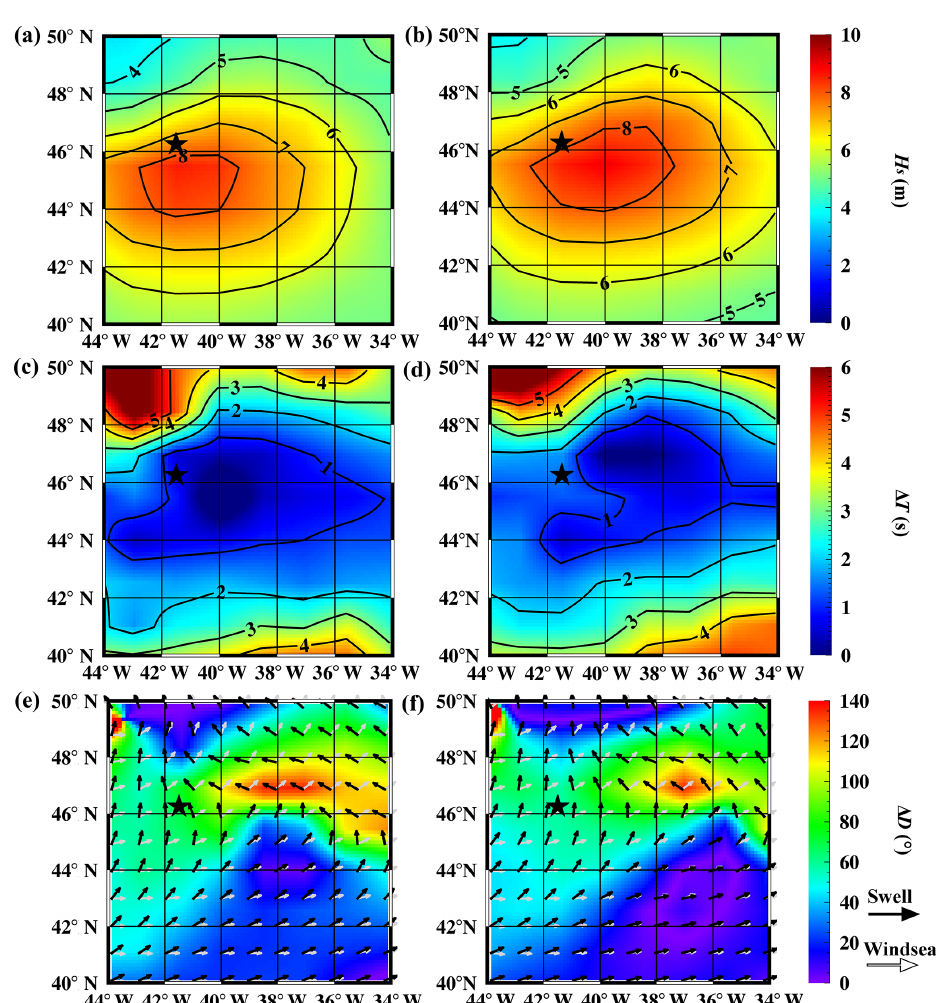
Figure 8. The sea state in the vicinity of the case that occurred on 10 January 2010. Panels (a) , (c) , (e) and (b) , (d) , (f) are the model results at 18:00 and 21:00UTC, respectively; panels (a) and (b) show H s , (c) and (d) show (cid:49)T and (e) and (f) show (cid:49) D. The accident location is marked with a black star. Arrows in the plots of the third row represent the wave directions of the swell (black) and the wind sea (light grey).